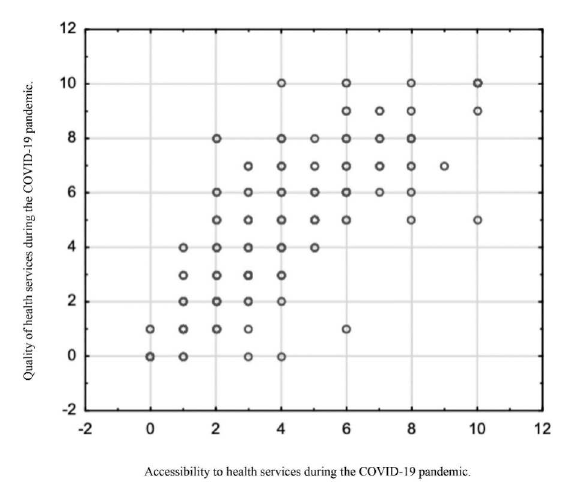
Figure 8. Correlation between accessibility and quality – assessment during the COVID-19